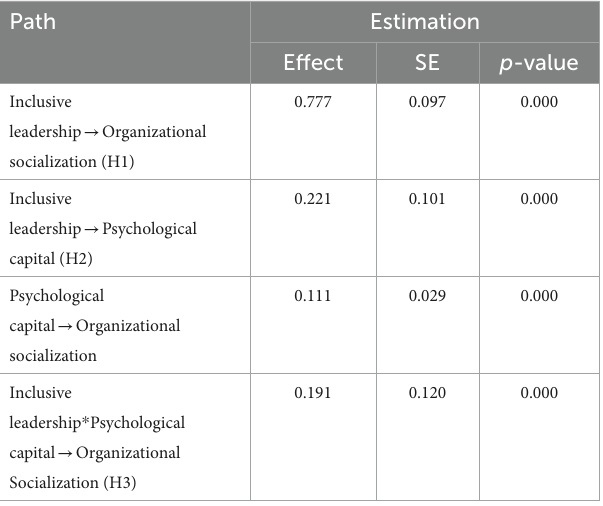
TABLE 7 Hypothesis Test